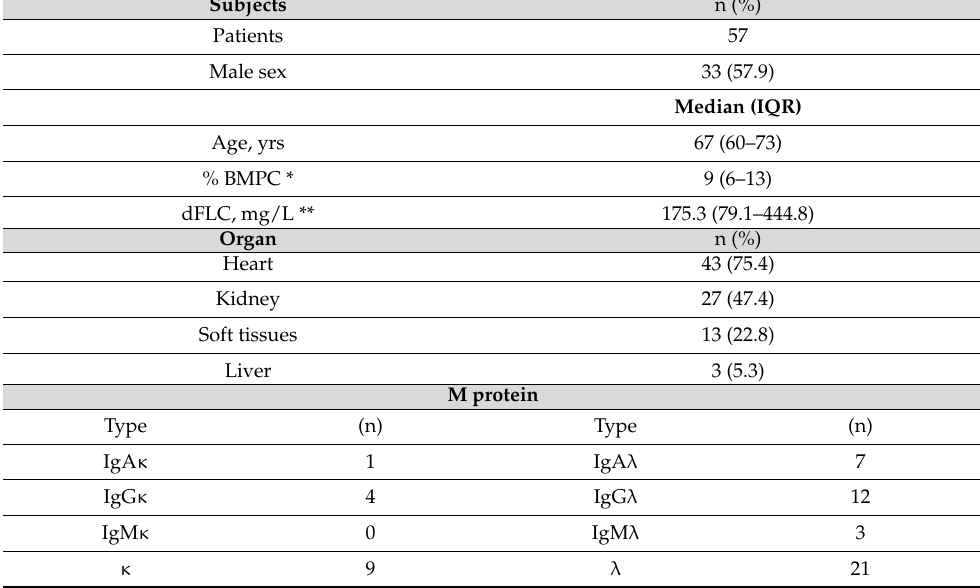
Table 1. Clinical characteristics of AL patients included in this study.